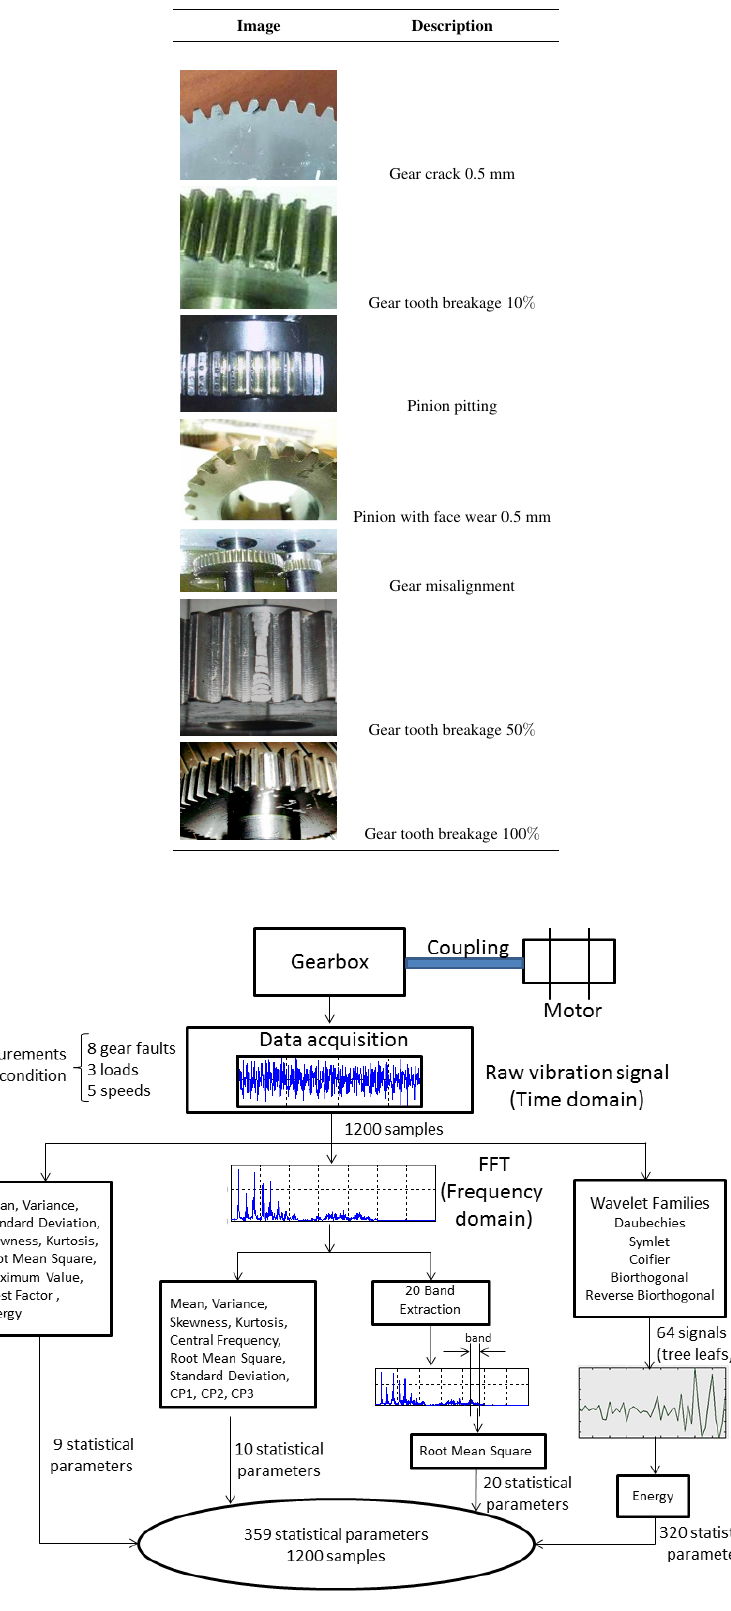
Figure 4. Feature extraction process from the vibration